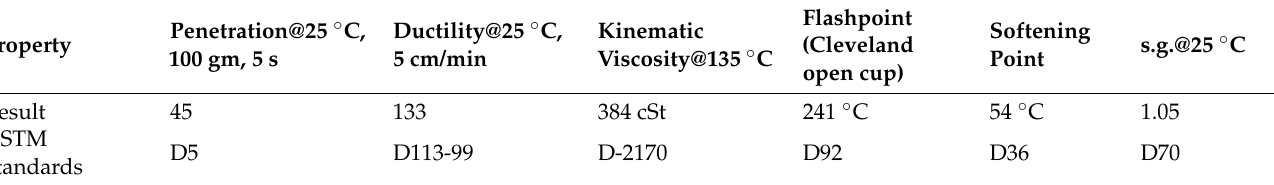
Table 5. Physical characteristics of the used